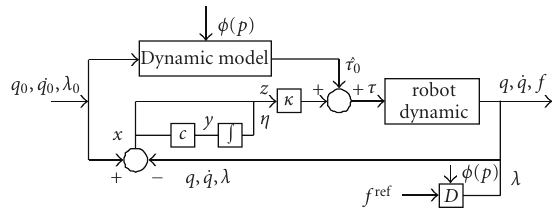
Figure 9: Insertion force control scheme for the slow subsystem. Disturbance d is given to MPC and its e ff ect is predicted and compensated before the e ff ect appears at the system output.